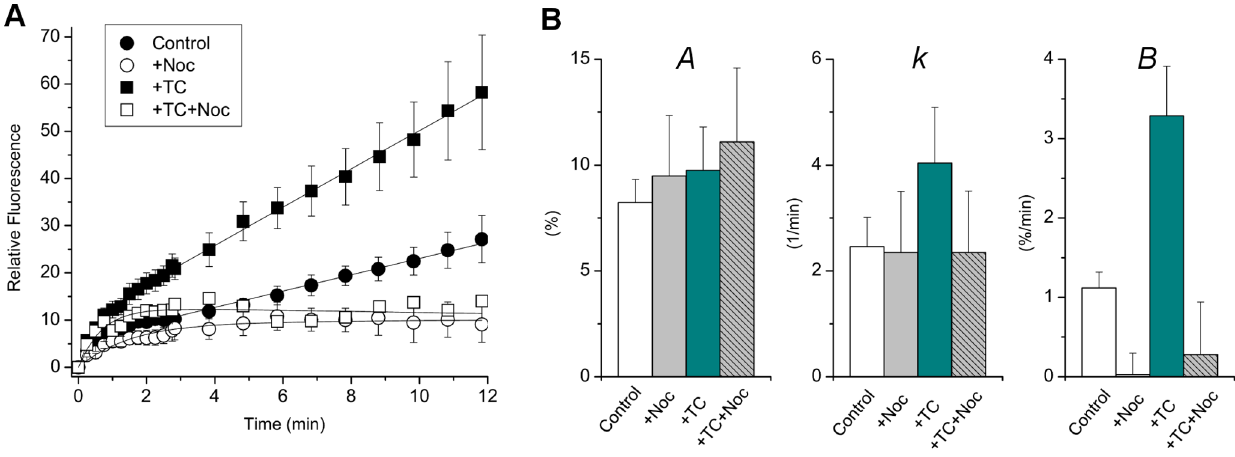
Figure 3. Taurocholate stimulates canalicular trafficking of ABCB11. ( A ) FRAP experiments with mouse hepatocytes expressing ABCB11-YFP N were performed as described in Fig. 2. Pretreatment with 100 m M taurocholate (TC) substantially accelerated the fluorescence recovery ( & ) as ). Nocodazole (Noc, 5 m g/ml) pretreatment blocked the second phase of biphasic fluorescence recovery compared to untreated control cells ( curves, while the first, saturating phase was not affected ( % , # ). Conclusively, the first phase presumably corresponds to lateral diffusion, whereas the second one reflects microtubule-dependent trafficking of ABCB11. ( B ) Kinetic parameters were determined by fitting the experimental points (see equation in the text). Only parameter B was significantly different between untreated and nocodazole-treated cells (p , 0.05). Means 6 S.E.M. of at least three independent experiments are shown.